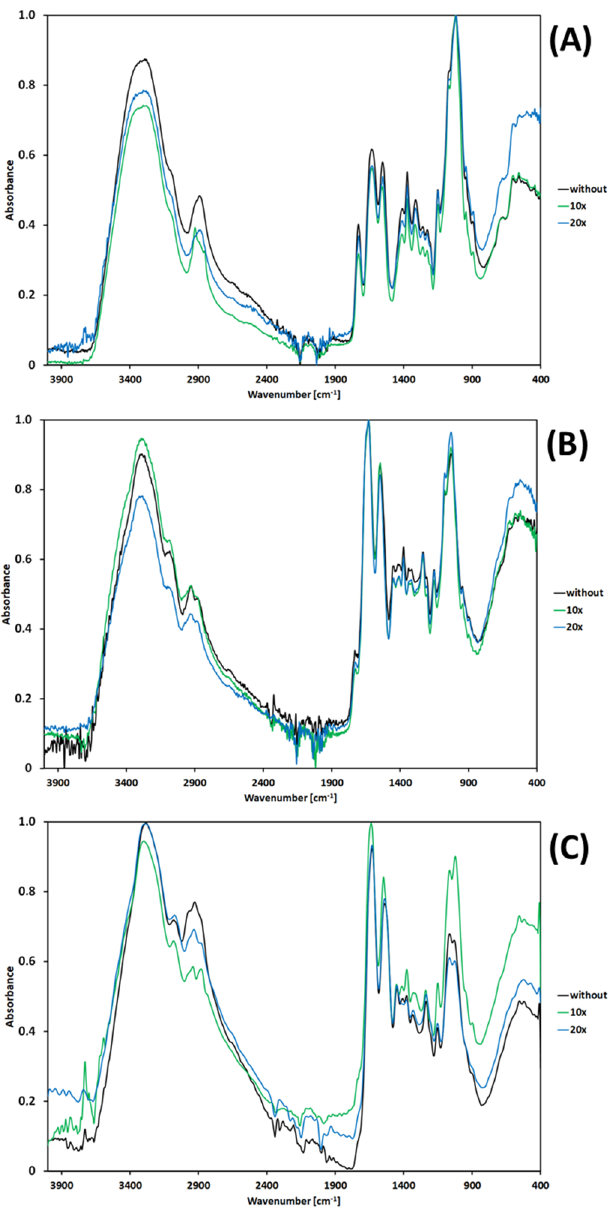
Figure 2. ATR-FTIR spectra of ( A ) HA, ( B ) Coll/HA, and ( C ) Coll//HA/30CTS films before and after dose of laser radiation.